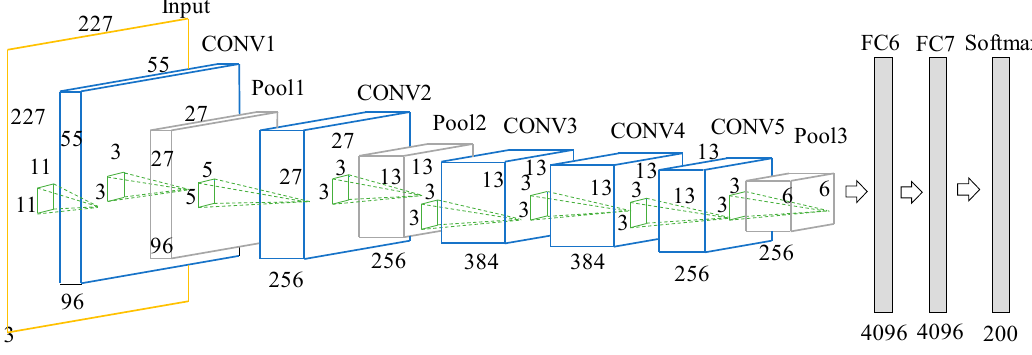
Figure 3. Structure of the CNN network based on the voiceprint identification.